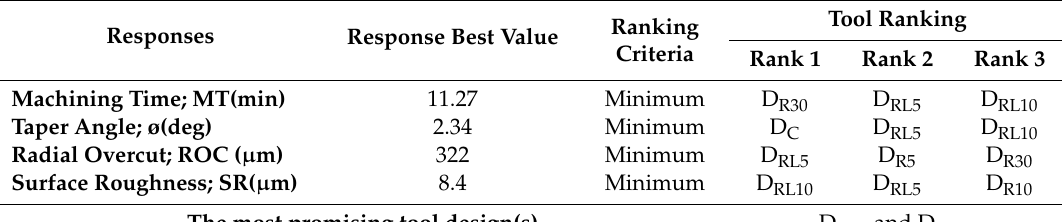
Table 5. Summary table to extract suitable